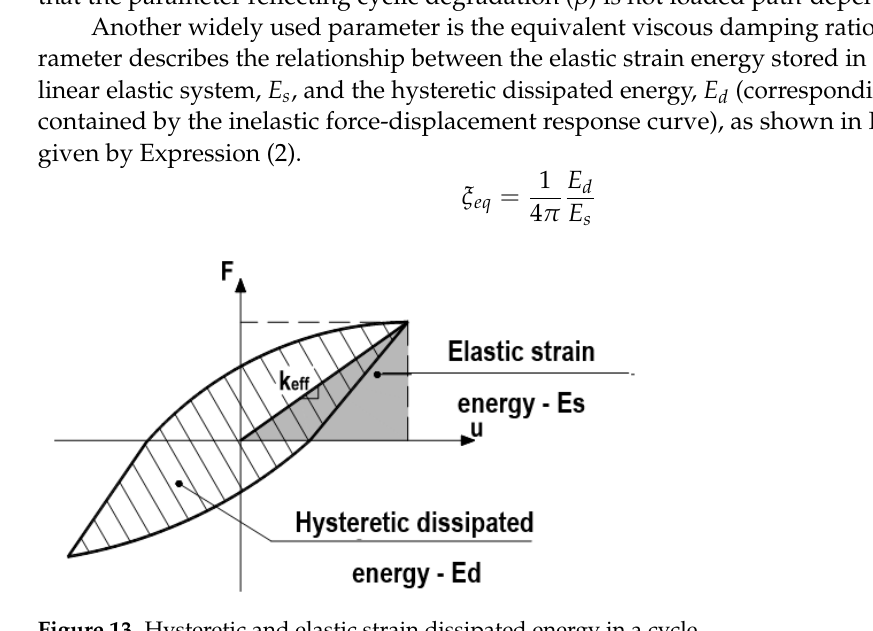
Figure 13. Hysteretic and elastic strain dissipated energy in a cycle.